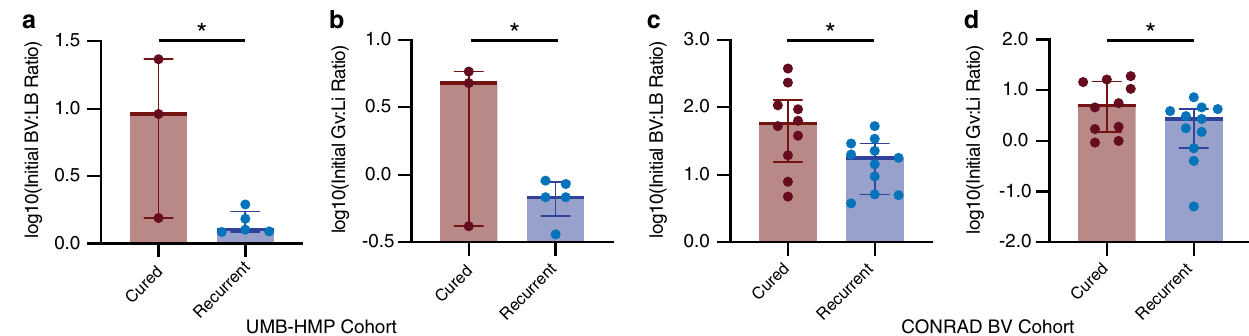
Fig. 5 Increased initial BV:LB ratios associated with successful treatment of BV. a , b Clinical results for the UMB-HMP cohort ( n = 3 individuals for the cured group, n = 5 individuals for the recurrent group) describing the a log base 10 transform of initial BV-associated bacteria relative abundance to Lactobacillus spp. relative abundance, p = 0.0366, t = 2.678, df = 6. b Initial Gv:Li ratio, p = 0.0497, t = 2.451, df = 6. c , d Clinical results for the CONRAD BV cohort ( n = 10 individuals for the cured group, n = 11 individuals for the recurrent group) describing c log base 10 transform of initial BV-associated bacteria relative abundance to Lactobacillus spp. relative abundance, p = 0.0242, t = 2.449, df = 19. d Initial Gv:Li ratio, p = 0.0338, t = 2.287, df = 19. Data are presented as median, 25th and 75th quartiles, statistical analysis was completed with unpaired, two-sided t -tests that were not adjusted for multiple comparisons. Source data are provided as a Source data